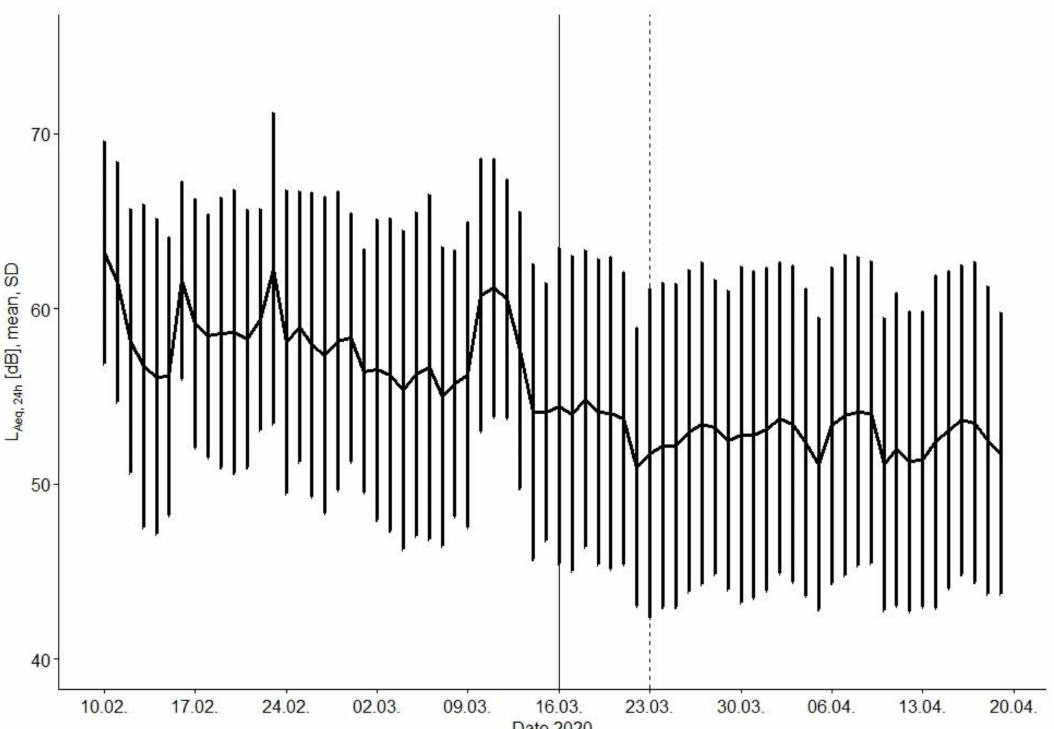
Figure 2. Development of noise levels, overall. Mean L Aeq,24h for all 22 devices and their corresponding standard deviation (SD) are shown. Vertical full and dashed line mark the dates 16 March and 23 March according to resolved